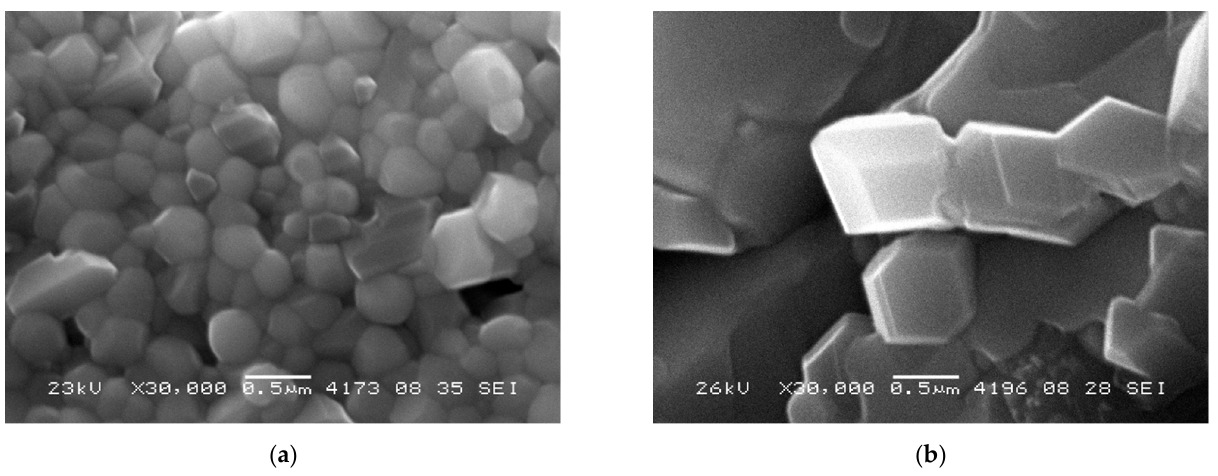
Figure 4. SEM micrographs of the NWO ( a ) and NWMO ( b ) samples obtained by mechanical activation and RTS at 1100 °C acquired from the base of the pellets.